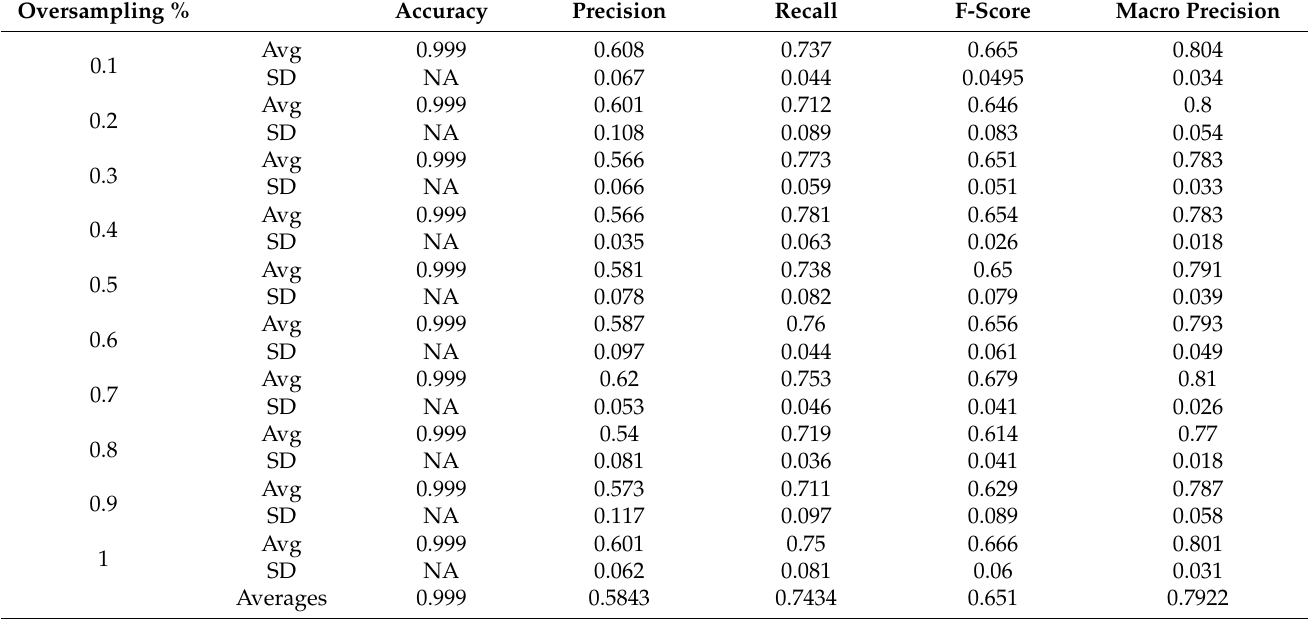
Table 15. UNSW-NB15: Worms—classification results for random undersampling after